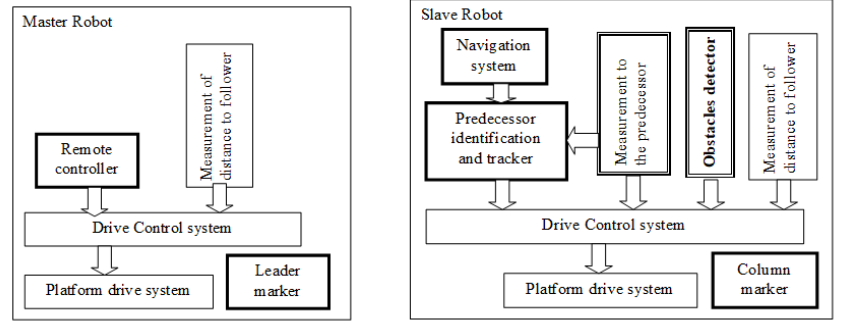
Figure 10. Developed structure of master and slave robots.